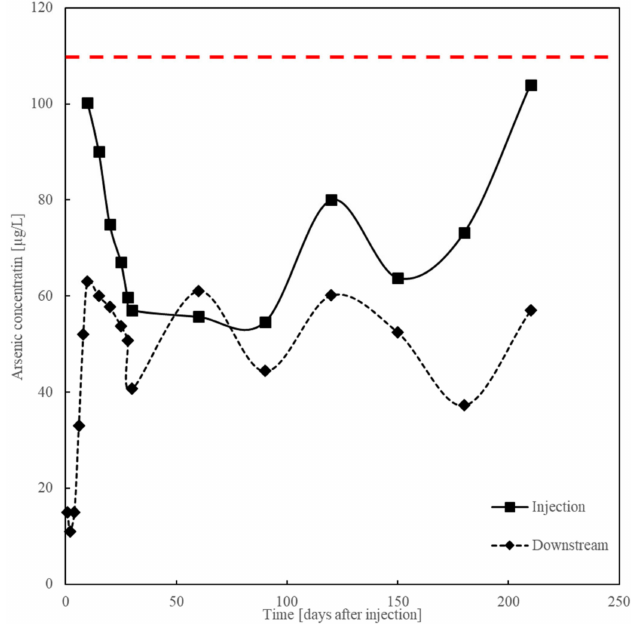
Figure 6. Observed arsenic concentrations in the injection and the downstream wells after injection of the iron oxide nanoparticles. Time 0 indicates the day of the